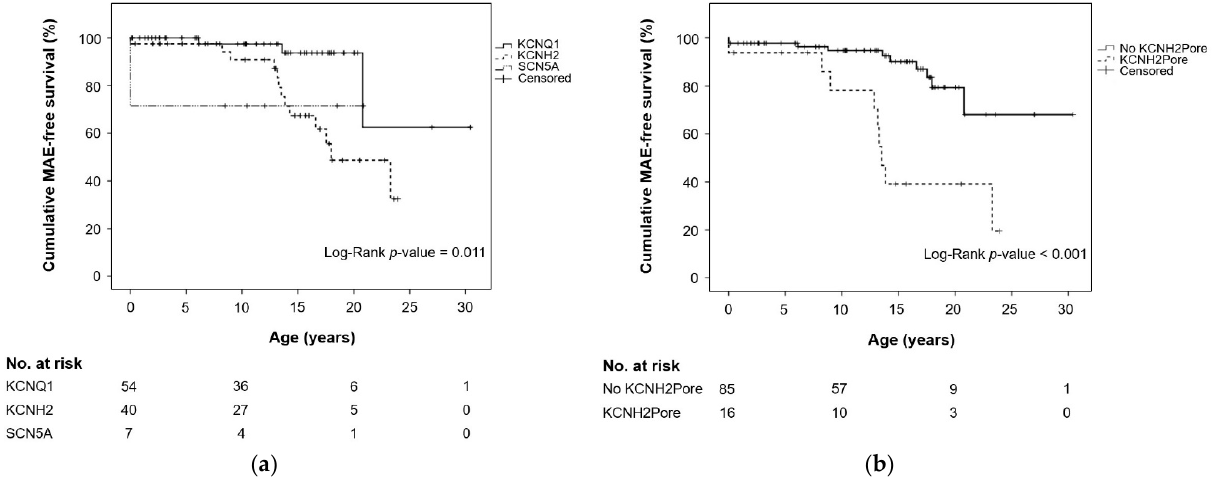
Figure 3. Kaplan–Meier estimates of survival without a major arrhythmic event (MAE) among the 101 patients with Long QT syndrome depending on ( a ) genetic locus of the variant and ( b ) location of the variant in the KCNH2 gene. KCNH2Pore: variant in the KCNH2 gene as well as in the S5-loop-S6 region (pore region). No KCNH2Pore: variant in the KCNH2 gene and not in the S5-loop-S6 region or variant in other genes ( KCNQ1 , SCN5A ). Table 3. Cox regression model: risk factors for MAE.